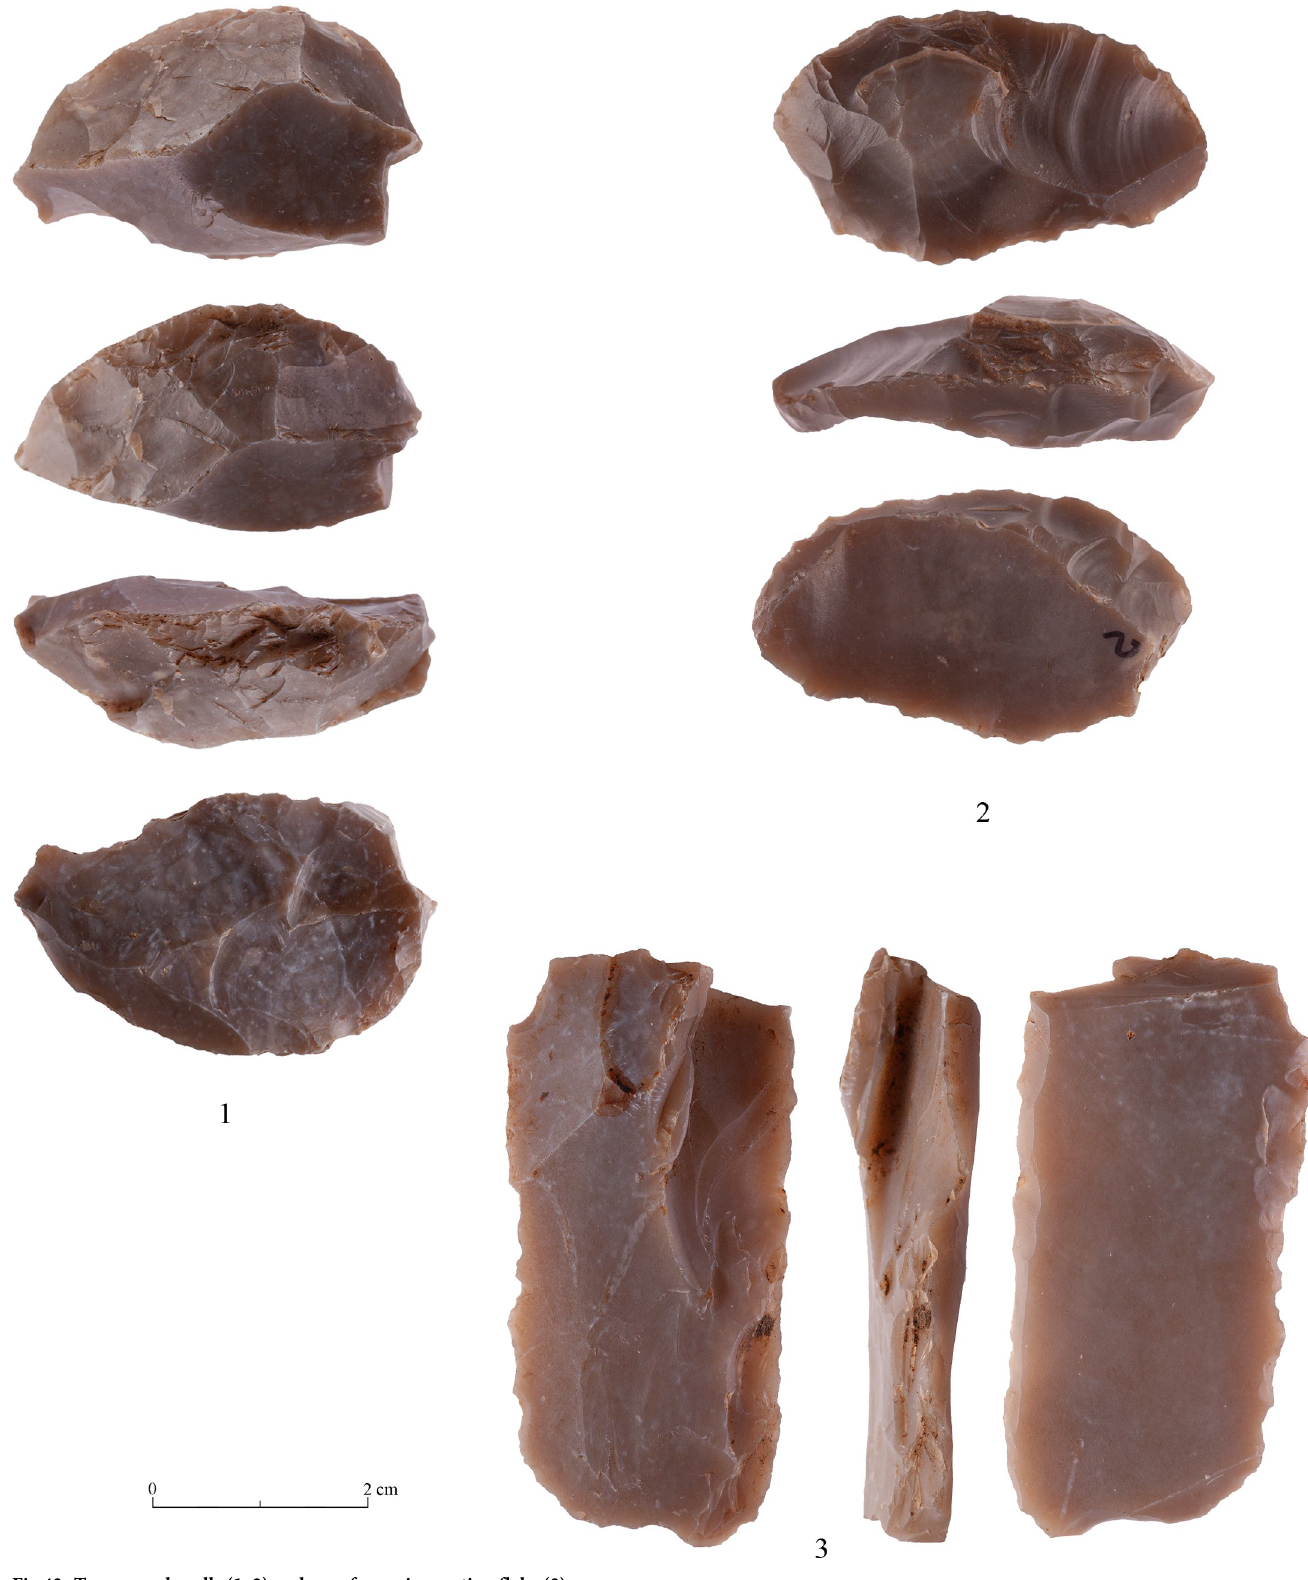
Fig 43. Transversal spalls (1, 2) and a surface-rejuvenation flake (3). https://doi.org/10.1371/journal.pone.0265727.g043 PLOS ONE | https://doi.org/10.1371/journal.pone.0265727 March 24,